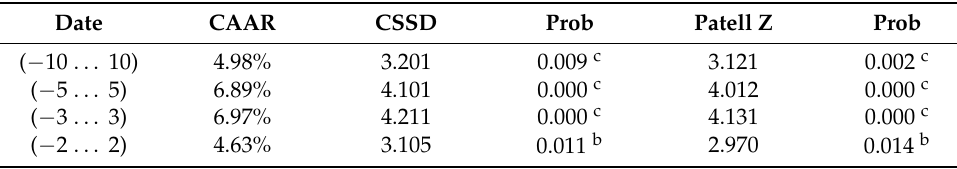
Figure 4. Cross-border acquisitions in US and UK. Source: Authors’ own calculation. Table 4. Results of parametric tests (US and